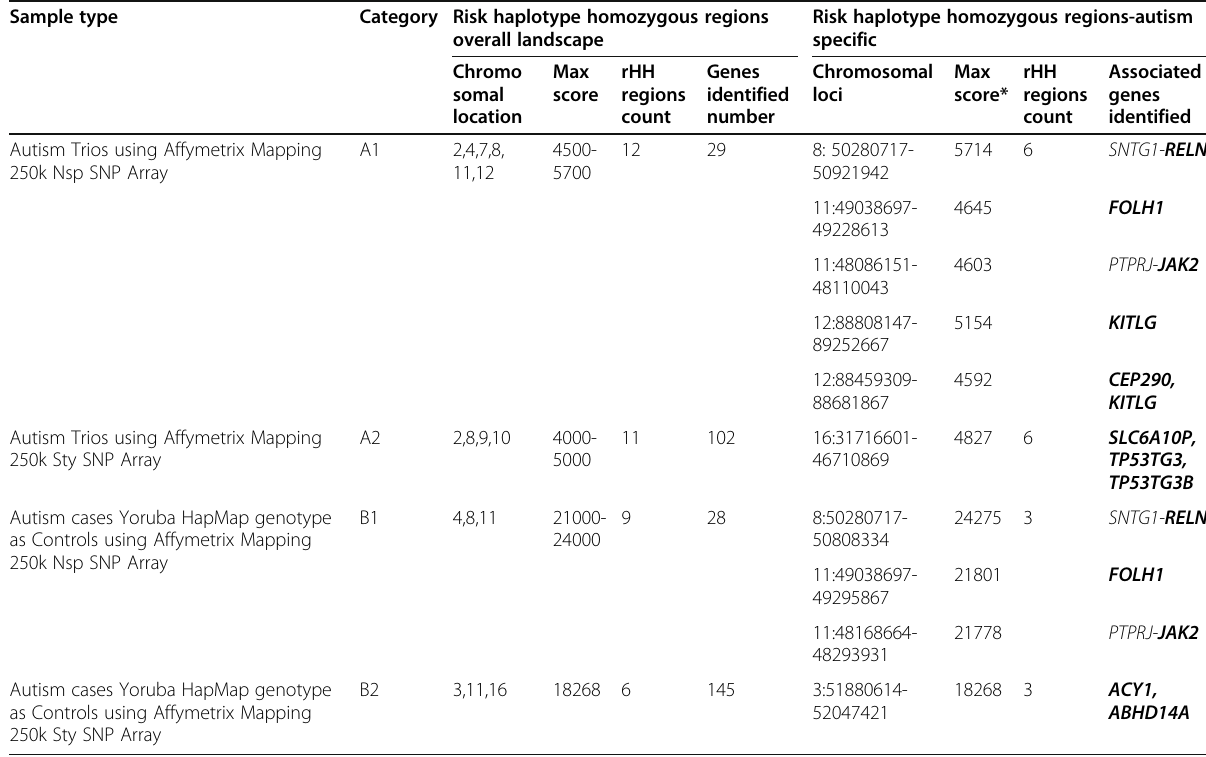
Table 1 Comparative risk homozygous haplotype regions among overall landscape and specific to autism Sample